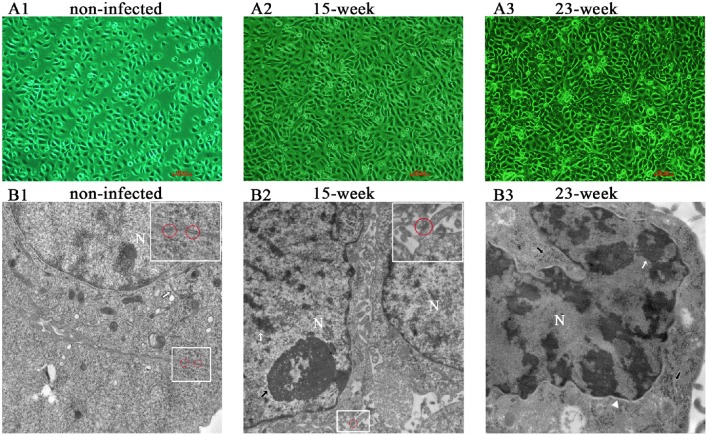
Cell morphological change after long-term exposure to P. gingivalis. (A). Morphological differences among HIOECs (non-infected), HIOECs-Pg-15 (15-week), and HIOECs-Pg-23 (23-week) were shown with inverted microscopy. HIOECs presented regular cobble-stone-like shape with obvious contact inhibition (A1 × 100) while infected cells were overlapped and showed irregular shape with more stretched cells (A2, A3 × 100). (B). Transmission electron microscopy showed the ultrastructure alteration. HIOECs showed regular nuclear/cytoplasmic ratio with rich and thick tonofilaments (white arrow) and multiple organelles (B1 × 20,000). The cellular junction between HIOECs was strong and composed of multi-desmosomes (red circle, partially magnified details at the top right corner, B1). HIOECs-Pg-15 and HIOECs-Pg-23 showed increased nuclear/cytoplasmic ratio, clearly abundant euchromatin and relatively simple organelles (B2,B3). The cellular junction of HIOECs-Pg-15 was weakened while few desmosomes were occasionally seen (red circle, partially magnified details at the top right corner, B2 × 10,000). The nucleoli and heterochromatin are respectively marked with black and white arrows (B2). The nucleus of HIOECs-Pg-23 became more deformed while obvious heterochromatin margination (indicated with a white arrow) was seen (B3 × 20,000). As shown with a white triangle, the perinuclear space was expanded (B3). Abundant ribosomes are shown with black arrows (B3).